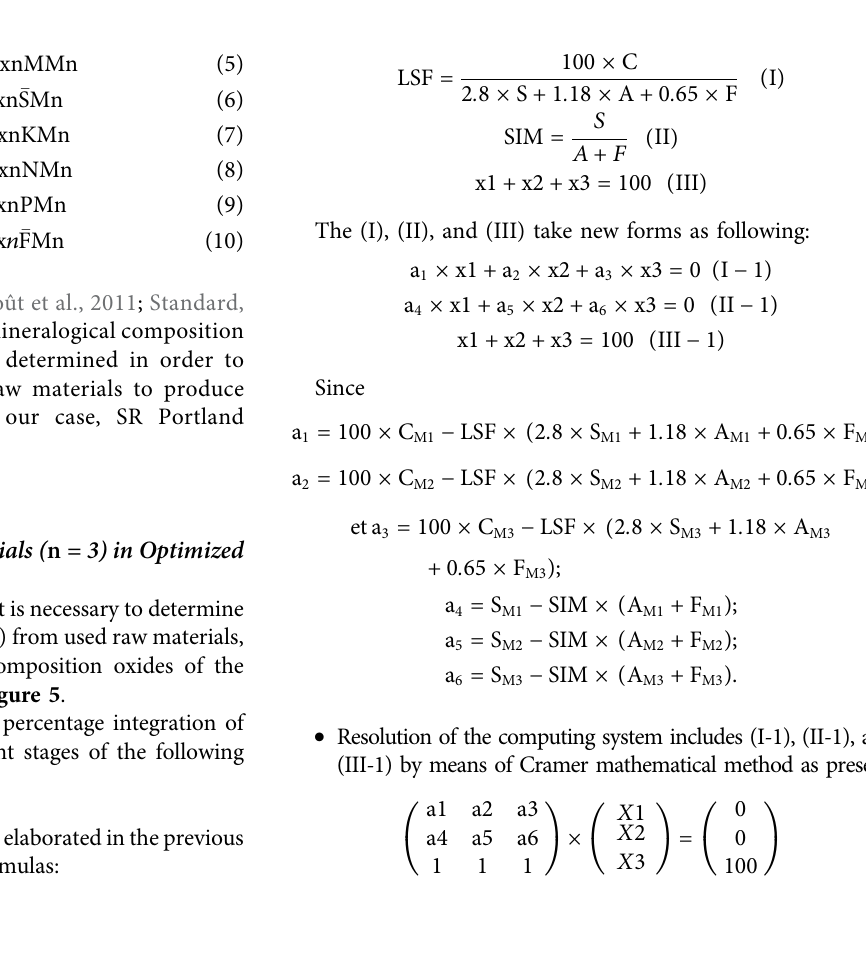
FIGURE 5 | Excel Sheet extracted from the raw meal calculation program which was based on three raw materials.